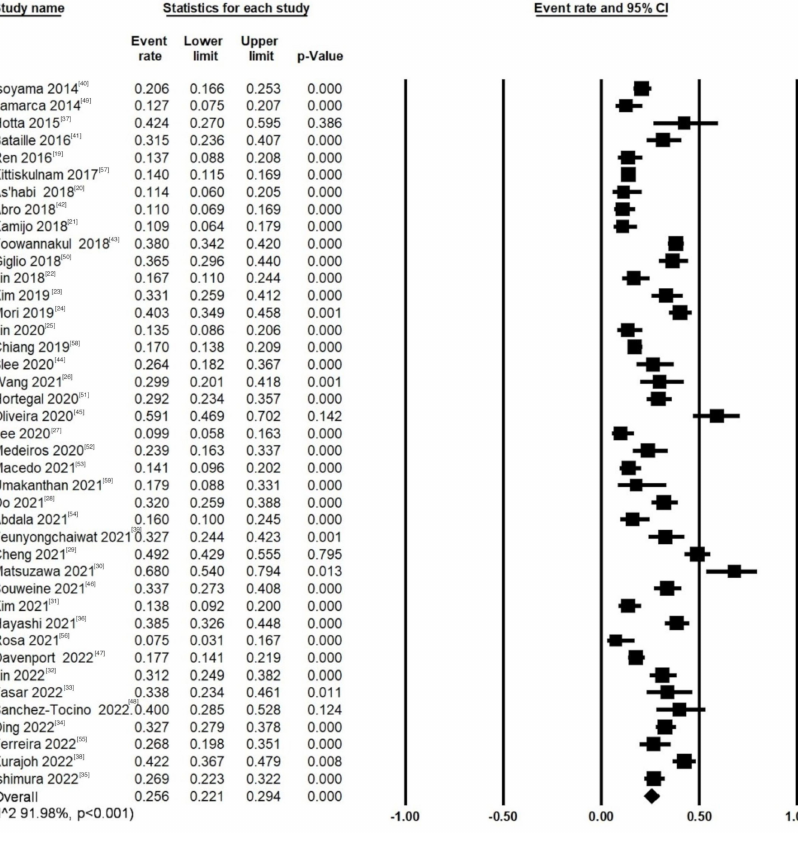
Figure 2. Forest plot visualizing the varying sarcopenic prevalence in dialysis patients reported as event rate for each study included publication in the meta-analysis